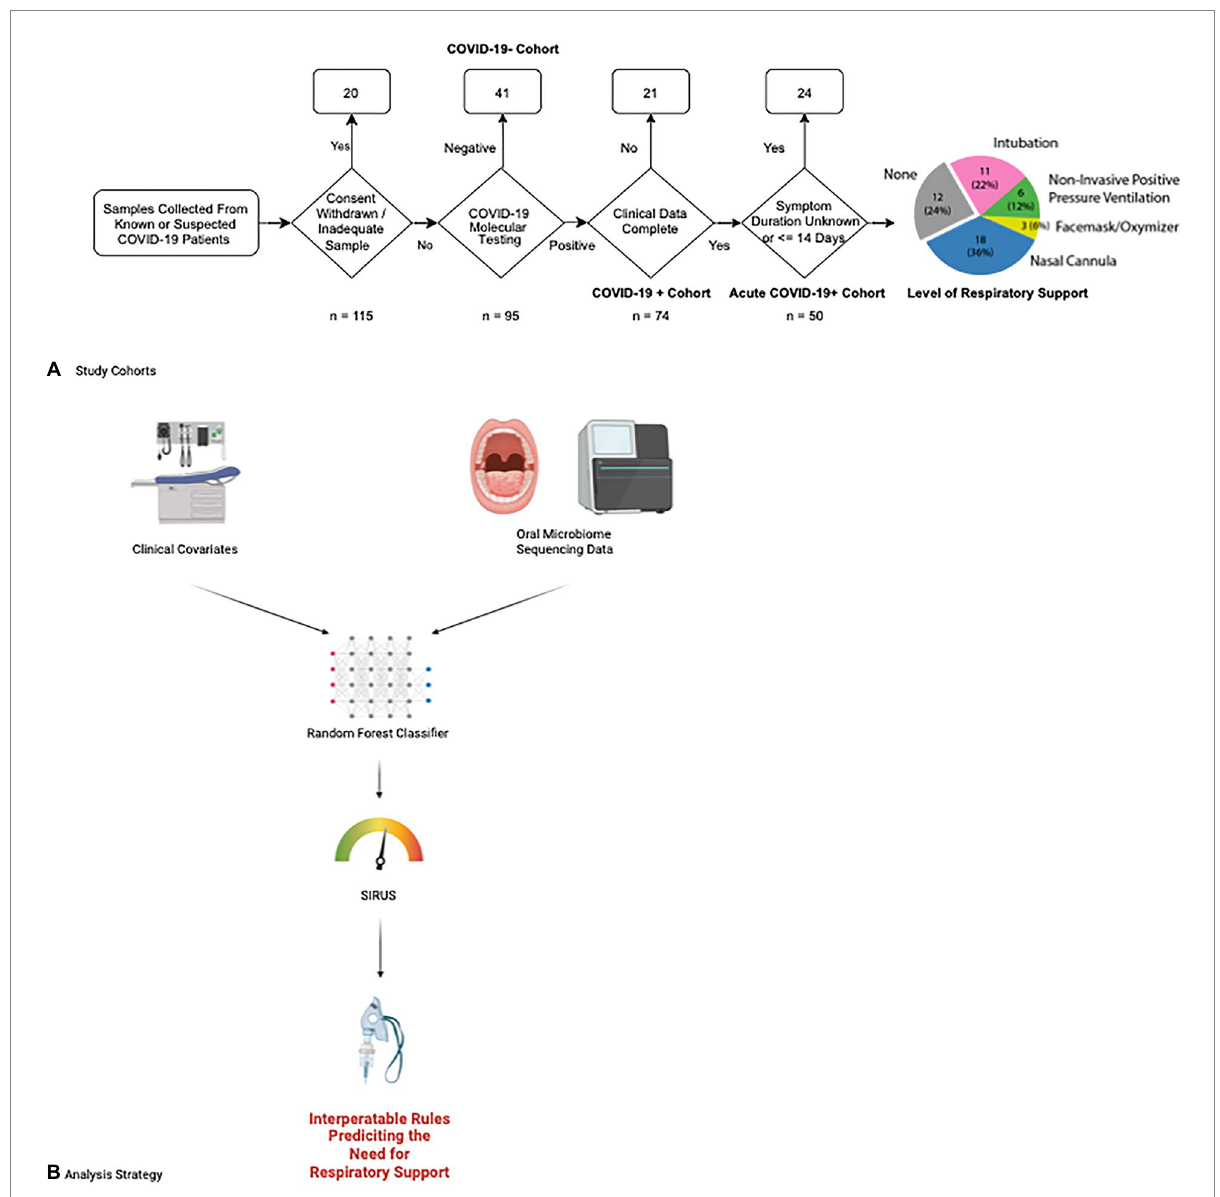
FIGURE 1 Study enrollment and data analysis flowcharts. (A) Patients at UMass Medical center were enrolled for our study according to the following flow chart. Fifty patients with acute COVID-19 were ultimately selected for our study cohort and followed for a clinical outcome of whether they needed respiratory support and what level of respiratory support was required, ranging from supplemental oxygen via simple nasal cannula escalating through intubation and mechanical ventilation. The number of patients requiring each level of respiratory support is shown in the